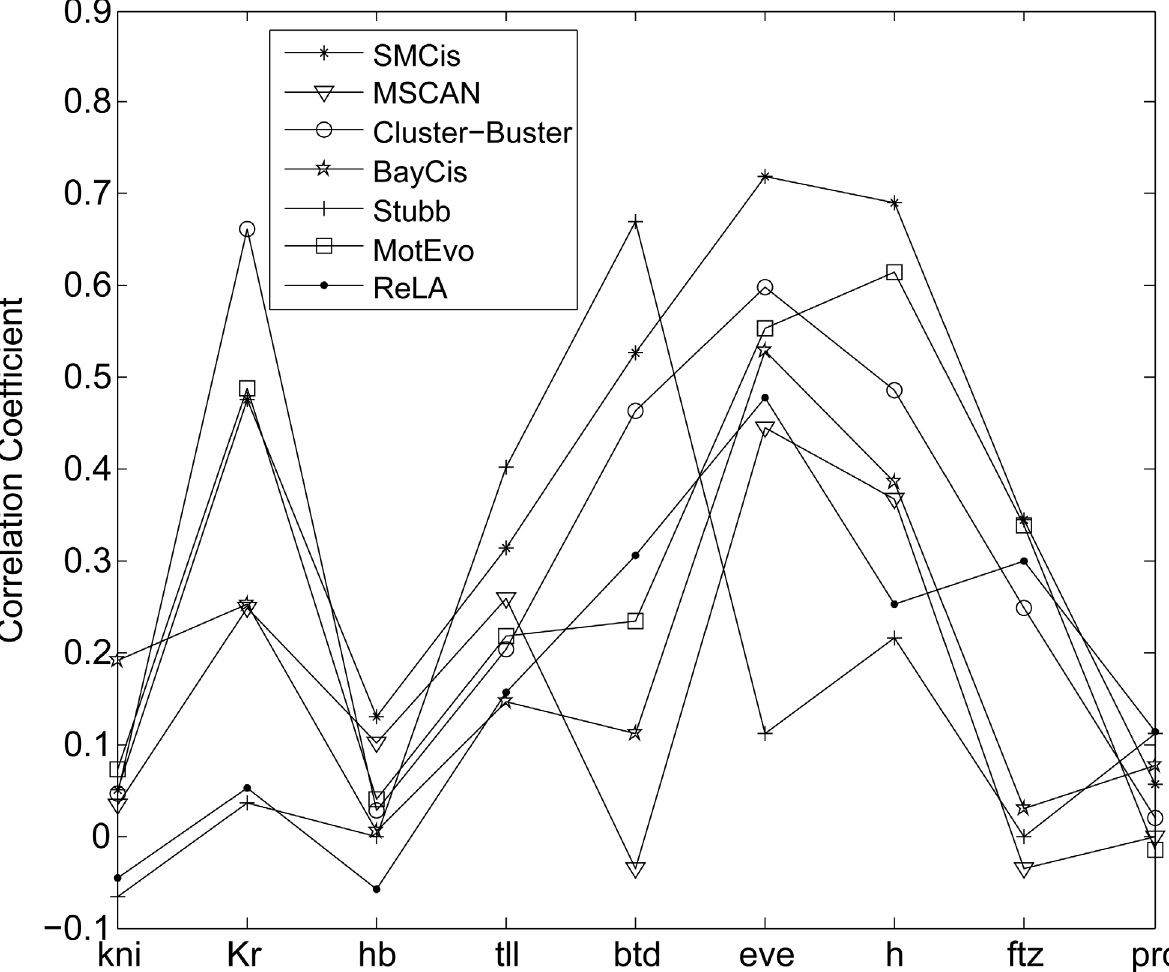
Fig 5. CC scores of all methods, calculated for single genes on the Drosophila early development